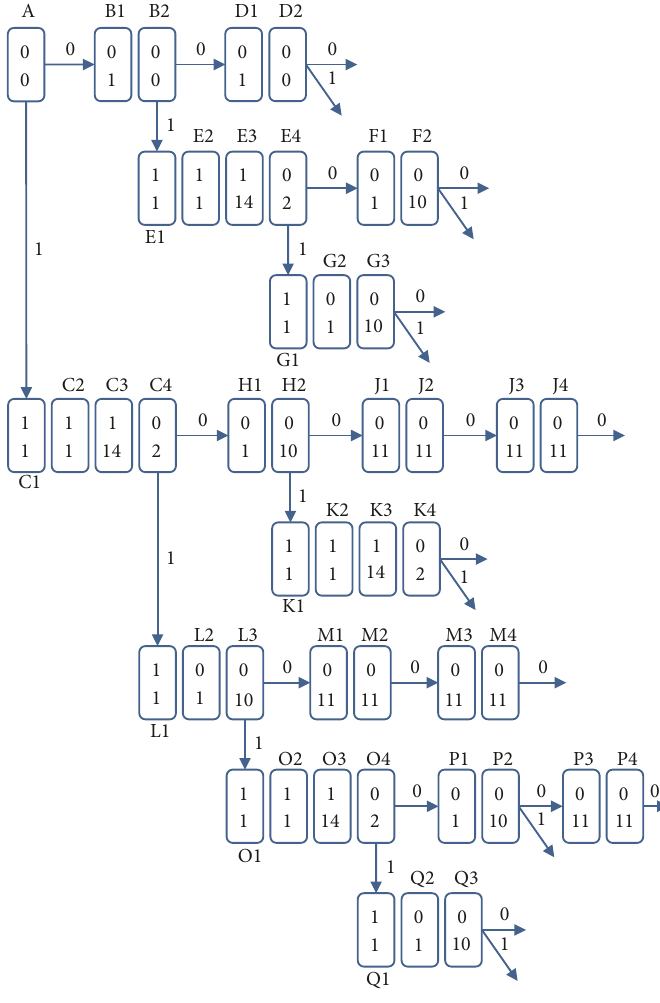
Figure 1: Iteration of full-time